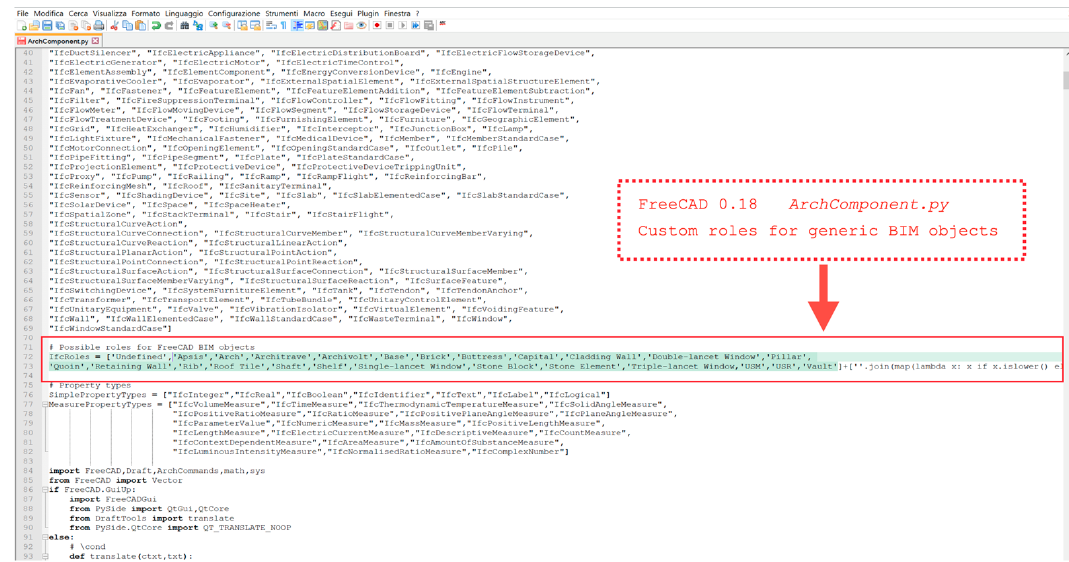
Figure 2. Access and modification of ArchWall.py Python file by using FreeCAD 0.17: highlighted in green are customized and possible roles for wall entity and related attributes below.